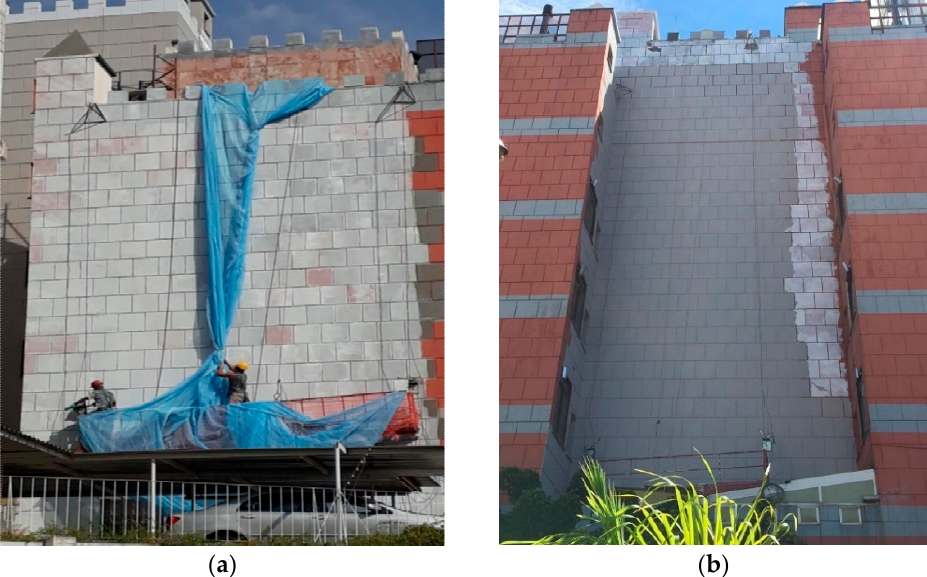
Figure 7. ( a ) Application of the primer coat; ( b ) application of the first coat of paint over the primer coat.